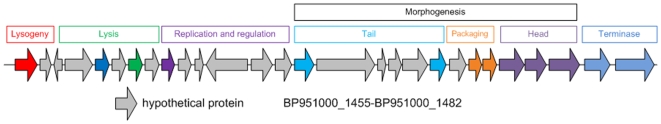
Organisation of the bacteriophage genome in B. pilosicoli 95/1000.